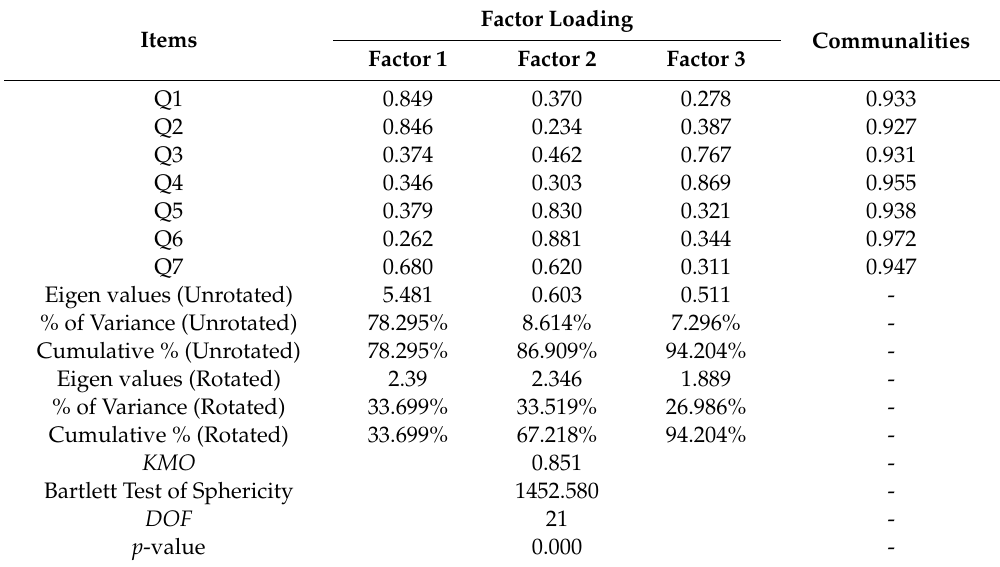
Table 4. Results of structure